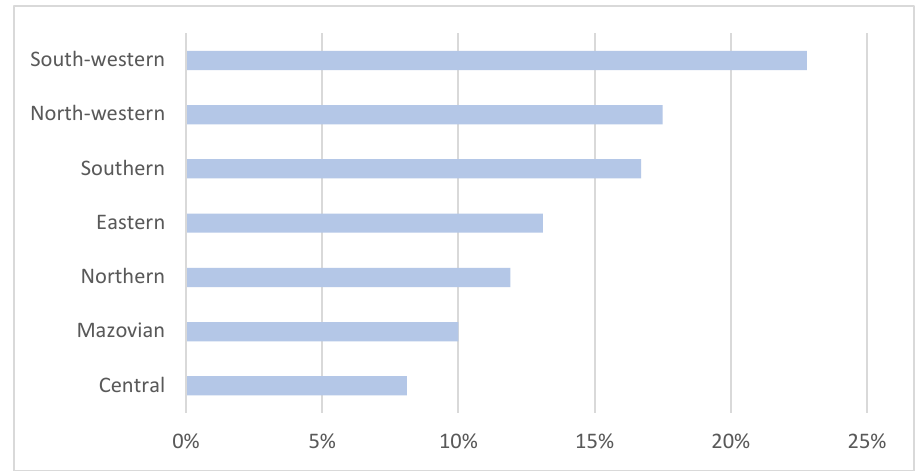
Figure 2. Characteristics of the survey population by macro-region ( n = 521) (source, own research).